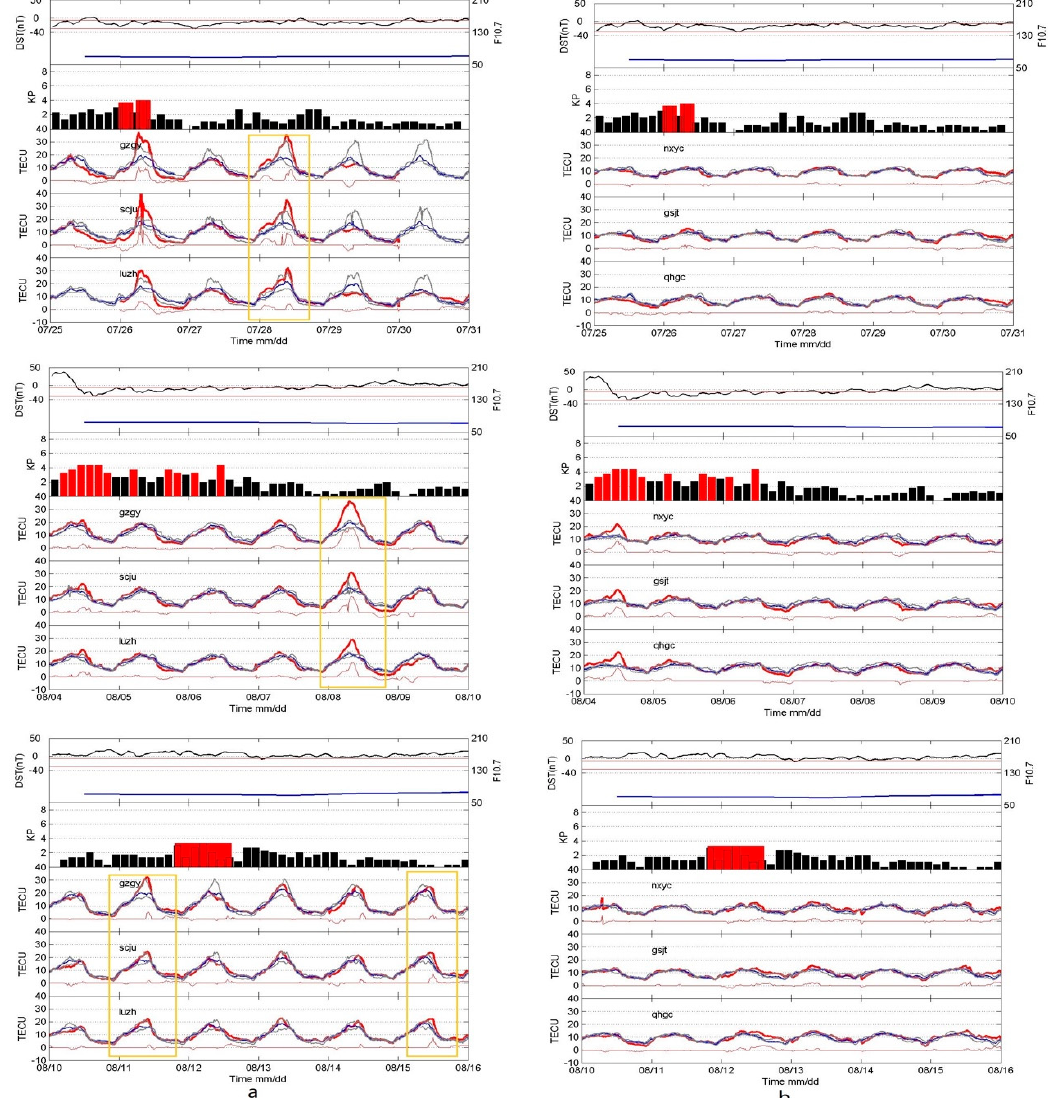
Figure 7. Total electron content (TEC) anomalies through sliding quarterback standard deviation of ( a ) seismic anomalies at the GZGY, SCJU, and LUZH stations and ( b ) aseismic anomalies at the NXYC, GSJY, and QHGC stations. Red thick lines denote observation data, blue lines show the mean curve, purple lines denote the threshold range of 2 σ , and red fine lines denote TEC anomalies.